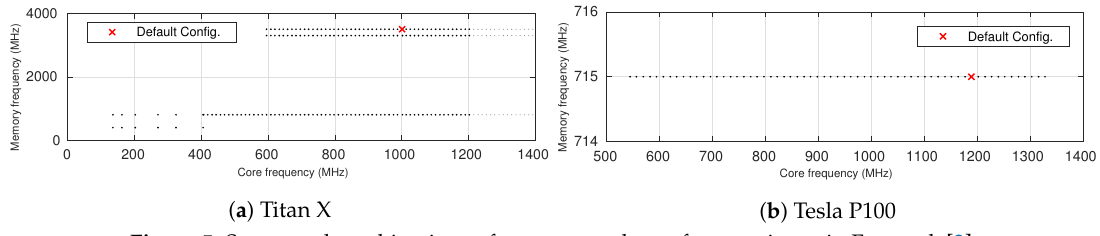
Figure 5. Supported combinations of memory and core frequencies as in Fan et al.